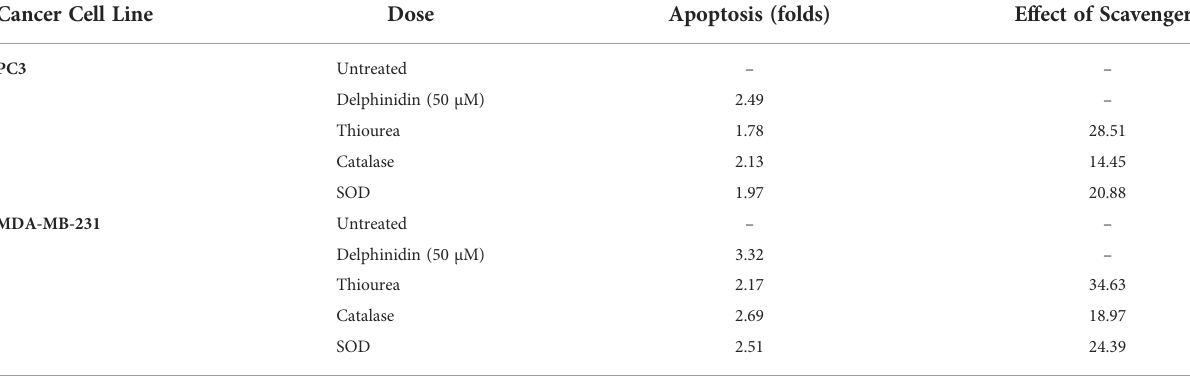
TABLE 1 The effect of ROS scavengers on the activation of apoptosis in two distinct cancer cell lines by delphinidin. Cancer Cell